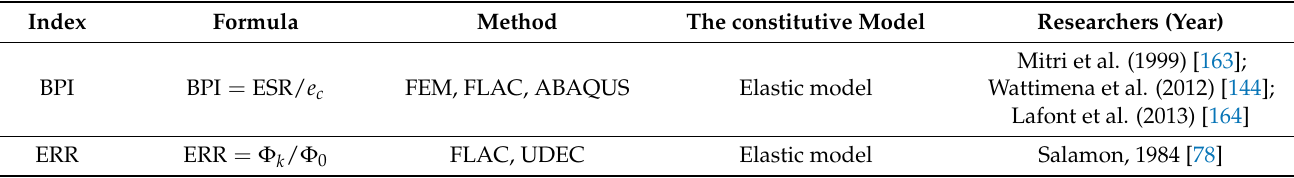
Table 8. Summary of pre-existing numerical simulation